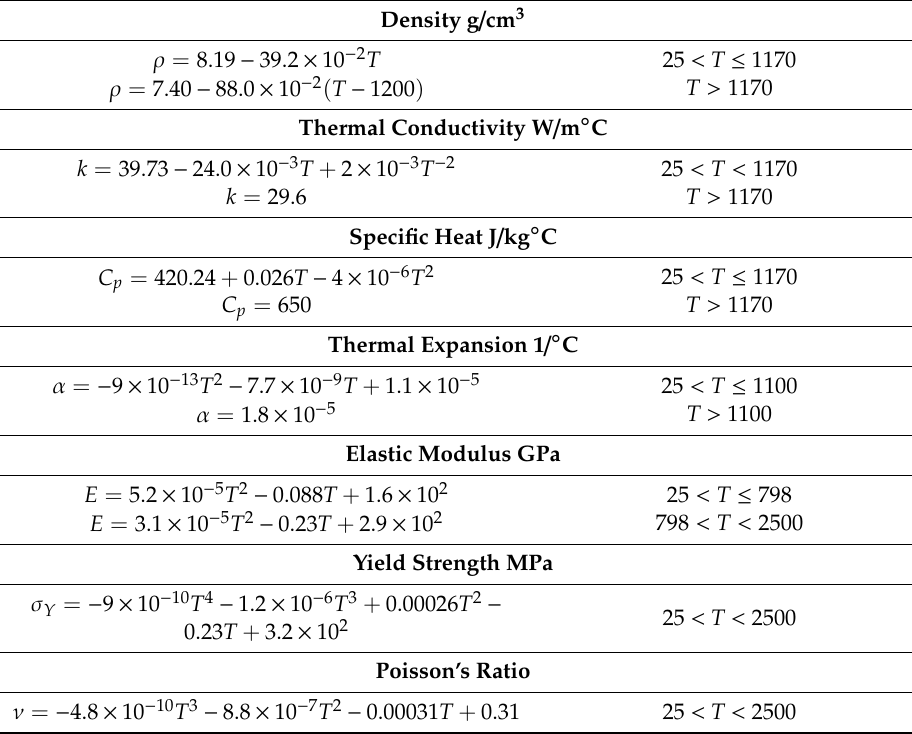
Table 5. Temperature dependent material properties of IN718 (temperature is in ◦ C) [37–41].